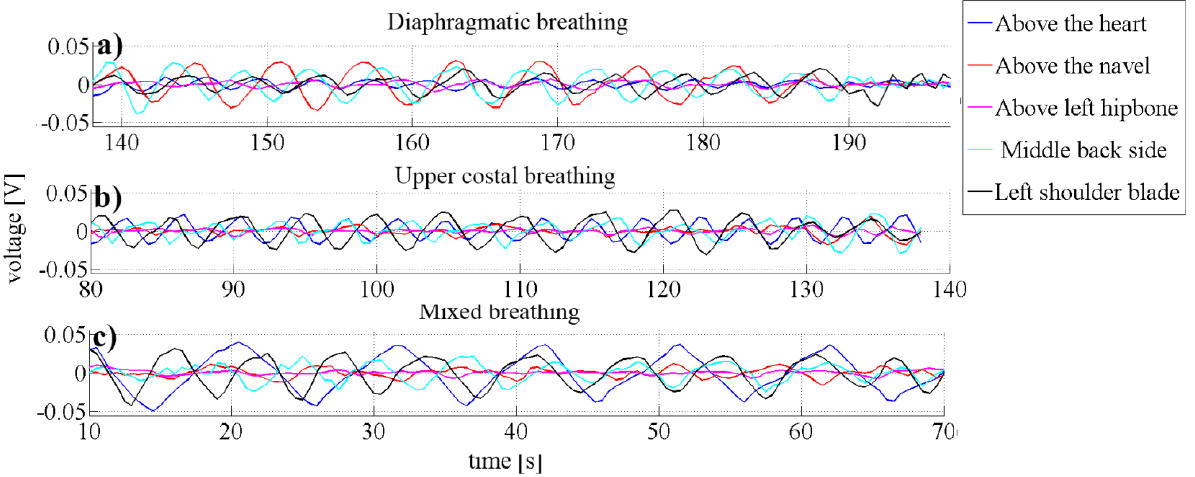
Figure 8. Graphs representing data from different types of breathing and data required to find out what is the best place on human body to measure respiratory